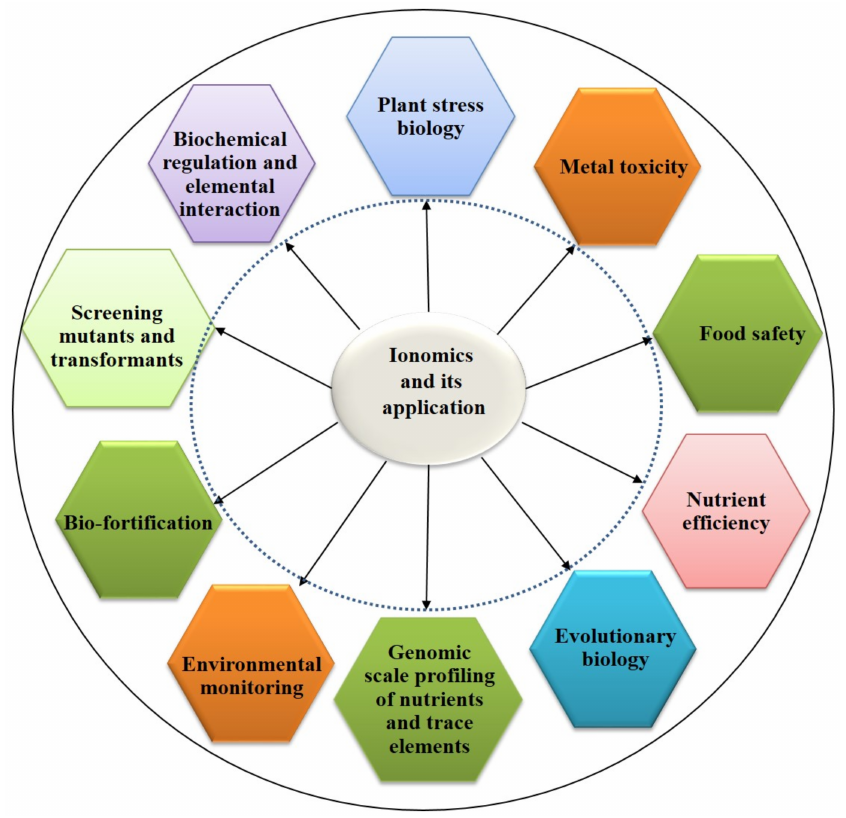
Figure 1. Overview of application of ionomics in human health and agriculture to identify different ions under diverse environmental